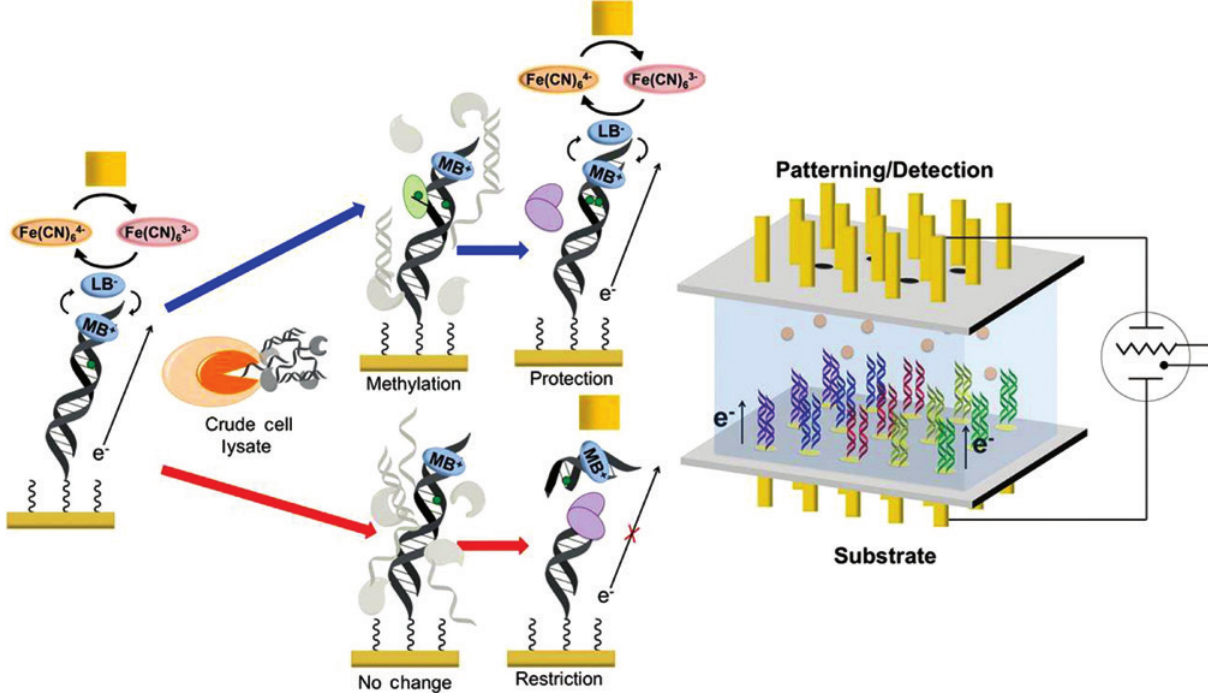
Figure 3: Electrochemical scheme (left) and platform (right) for the detection of human methyltransferase activity from crude cell lysates. (Left) Overview of electrochemical detection scheme at the electrode. Crude cell lysate is added to the electrode containing the patterned DNA. If methyltransferase (green) is present (blue arrows), the hemimethylated DNA on the electrode is methylated (green dot) by the methyltransferase to a fully methylated duplex; if methyltransferase is not present (red arrows), the hemimethylated DNA is not further methylated. A methylation-specific restriction enzyme, Bss HII (purple), is then added, cleaving only hemimethylated duplex, leading to a diminished signal. If the DNA is fully methylated, DNA is not cleaved and the electrochemical signal associated with methylene blue (MB + ) binding to DNA remains protected. (Right) The electrochemical detection platform contains two electrode arrays, each with 15 electrodes in a 5 × 3 array. Reprinted from Furst et al. (2014) with permission from Proceedings of the National Academy of Sciences of the United States of America.